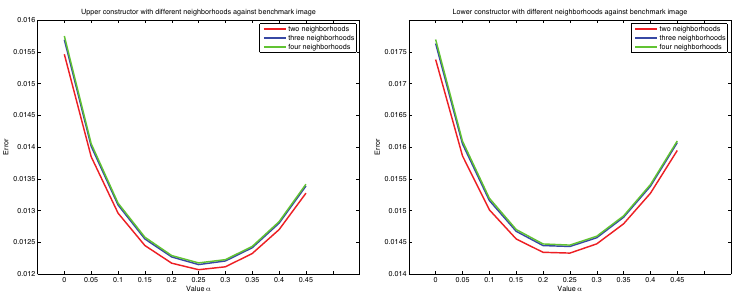
Figure 8: Upper (left) and Lower (right) constructors using C 5 weighting method and 2 , 3 and 4